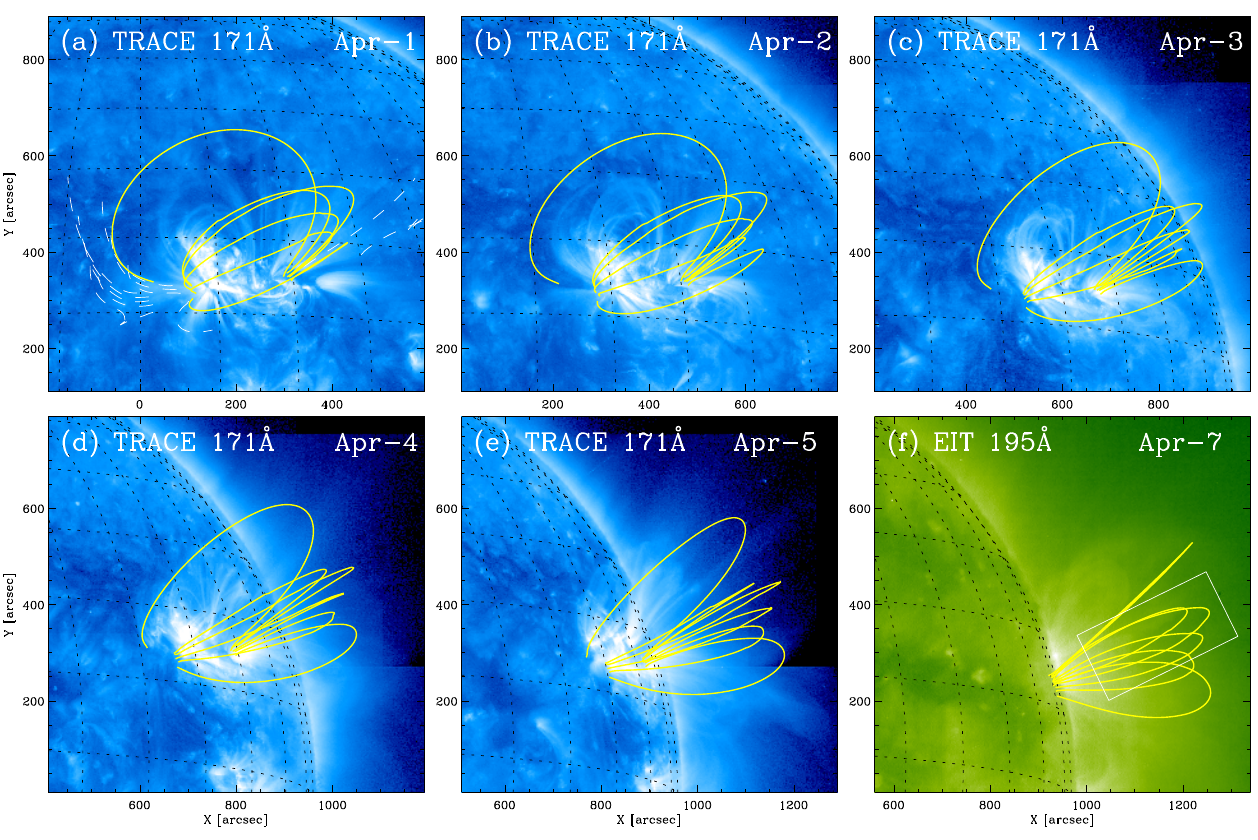
Fig. 3. The active region configurations seen in the EUV wavelengths with solar rotation in one week. The yellow lines are made by the PFSS method extrapolation and they are overlaid on the EUV images for configurational comparison. The white rectangle region in the last frame (7 April) shows the field of view of the SOLARC observation.